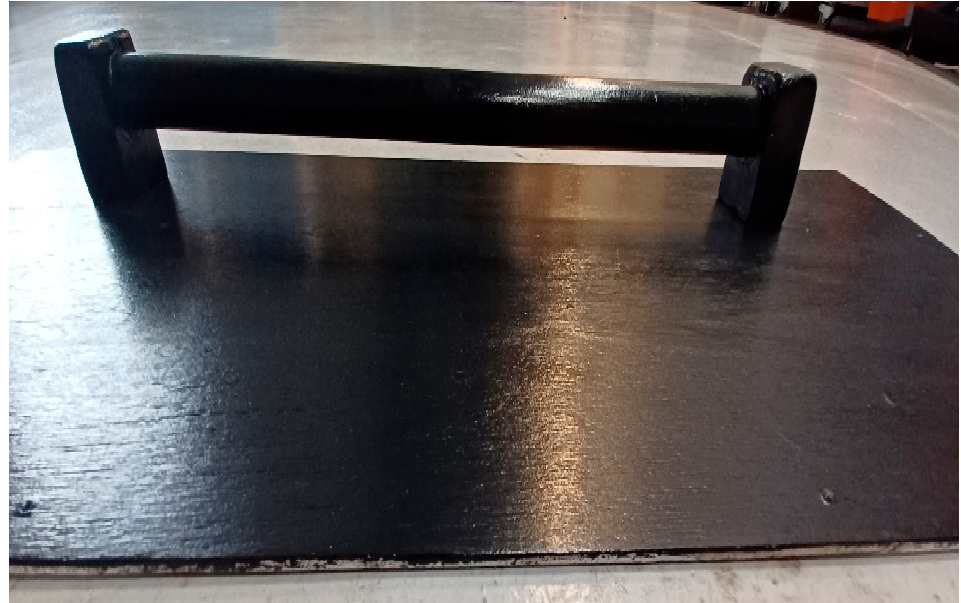
Figure 5. Board plate and handle used to mimic touch points.